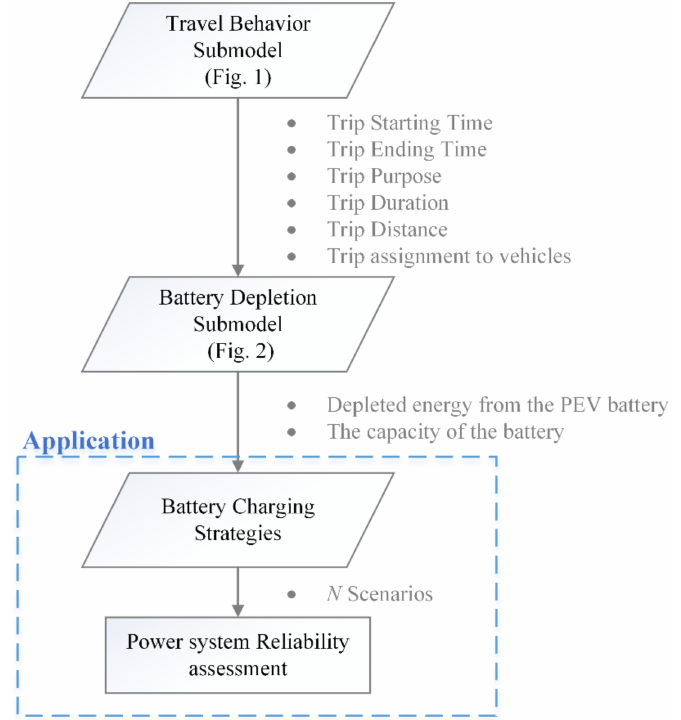
Figure 4. The integration of the proposed model with the Reliability